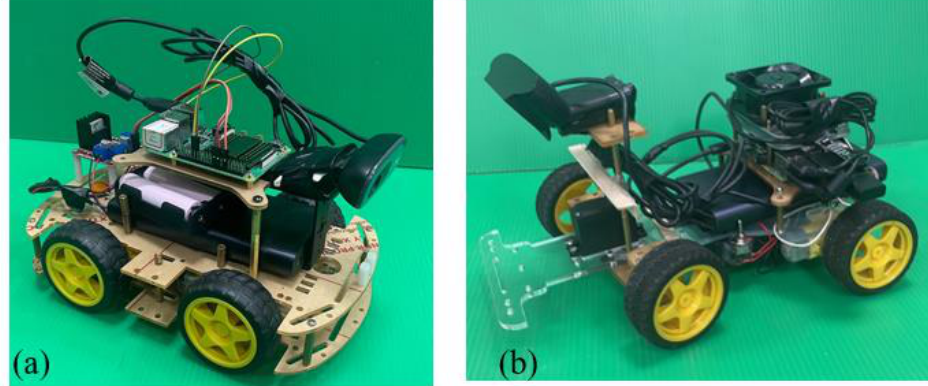
Figure 14. Photos of the two vehicles: ( a ) Vehicle A, steered by controlling the rotational speed difference between left and right wheels, and ( b ) Vehicle B, steered by controlling a servo motor.